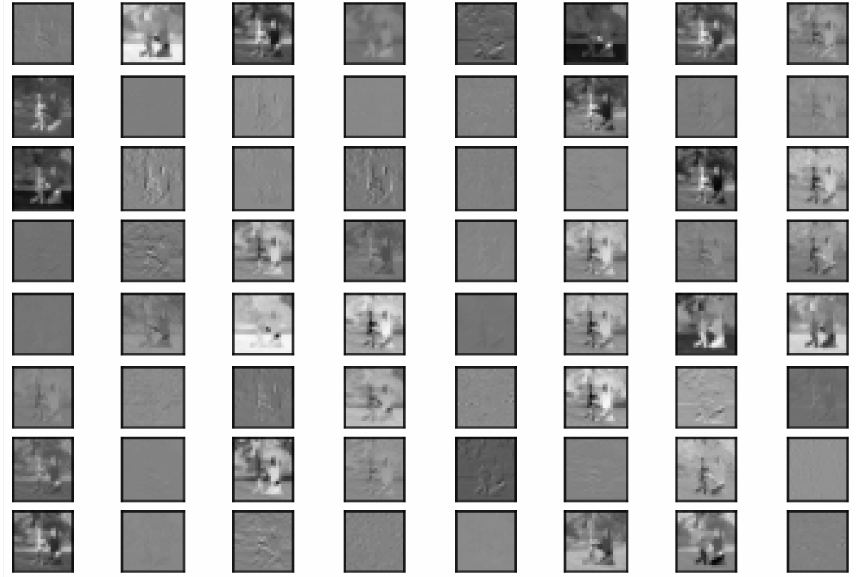
Figure 12. Feature map from initial convolutional layer (Conv 1) of the ResNet50V2 model.